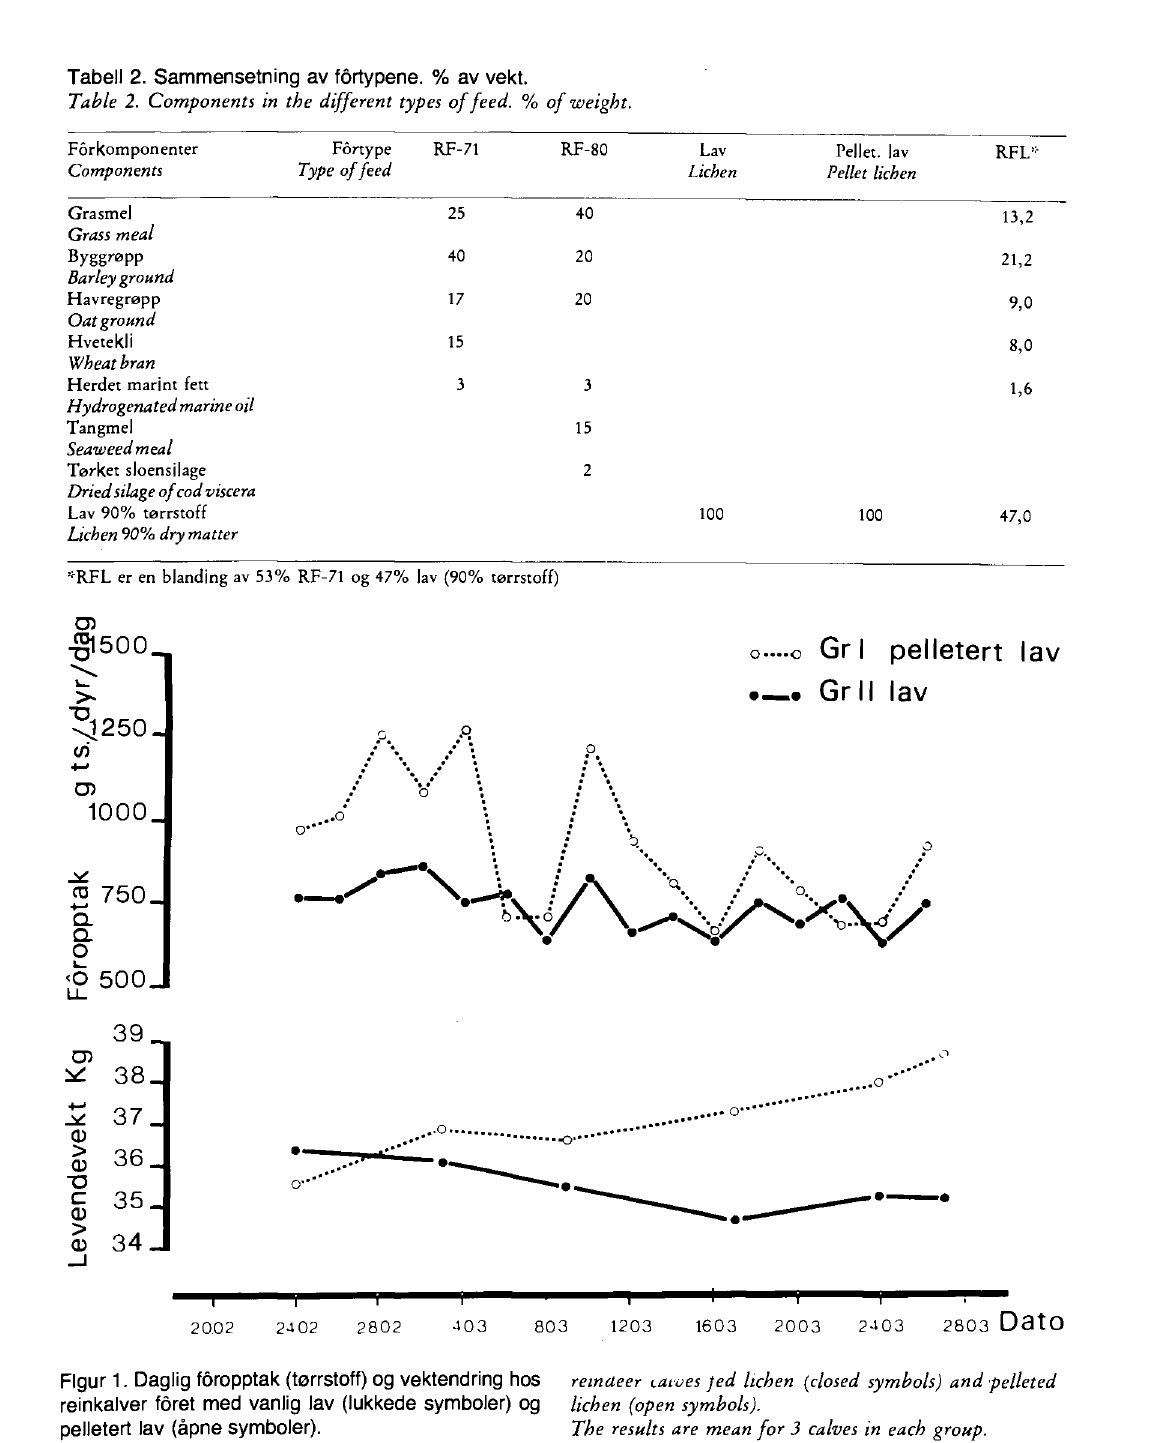
reindeer caiues Jed lichen (closed symbols) and pelleted lichen (open symbols). The results are mean for 3 calves in each group. Lav = lichen. Levende vekt = Live weight. Foropptak = Feed intake. Dyr = Animal. Dag =